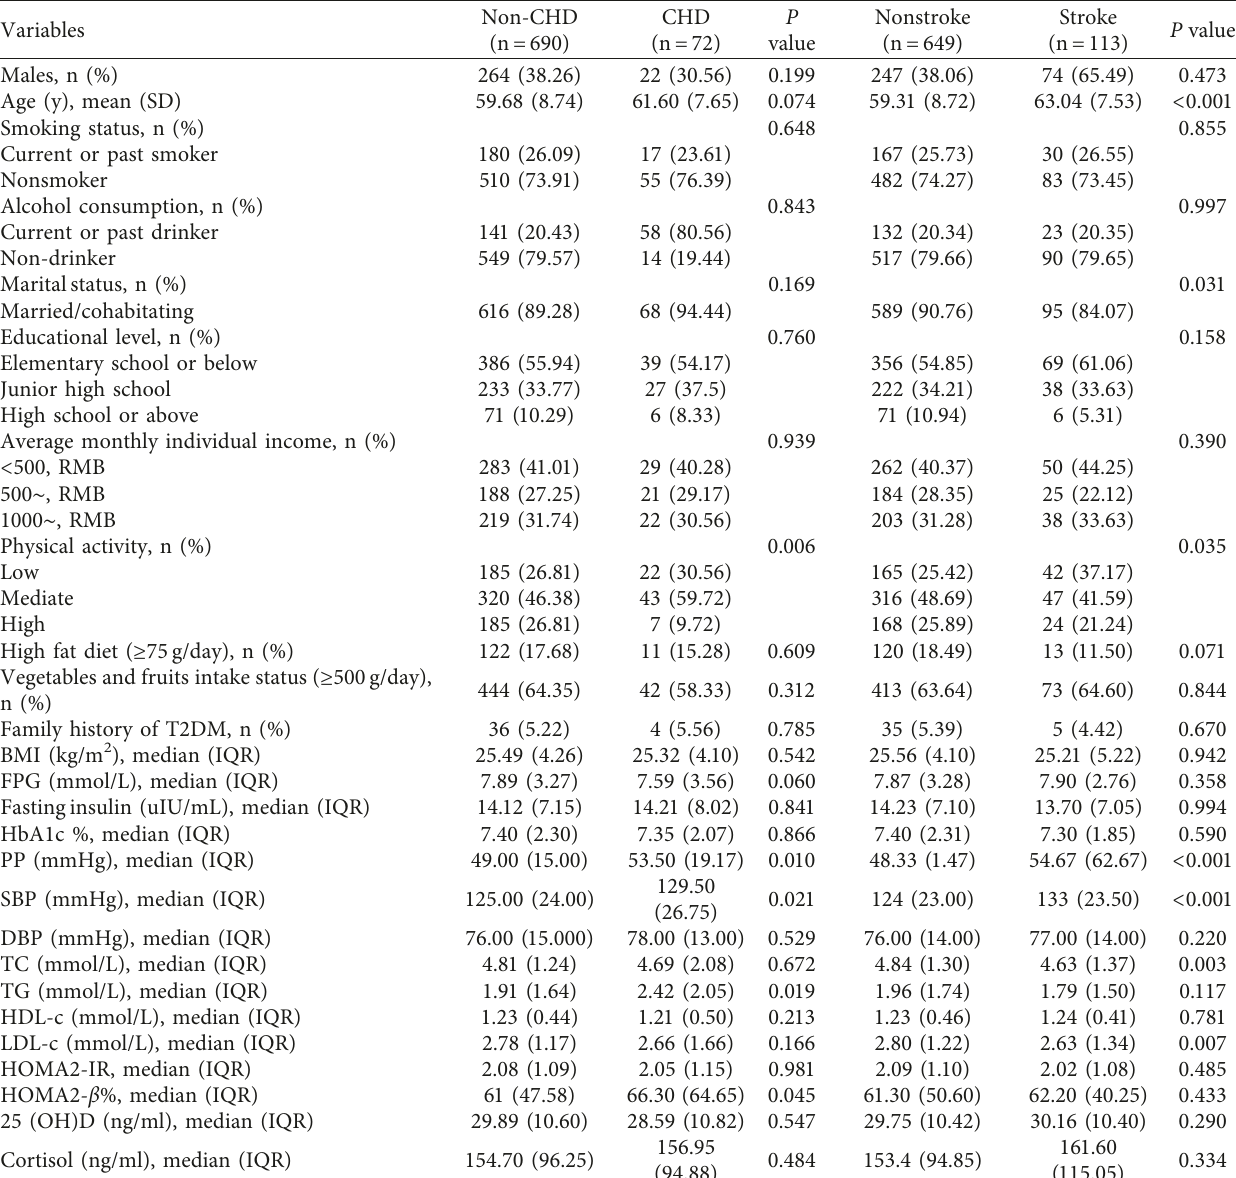
Table 1: Basic characteristics of the study population.